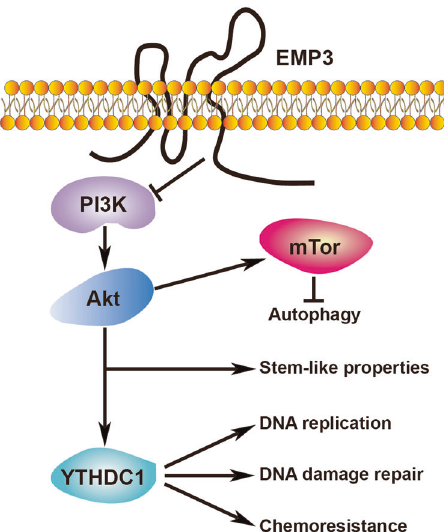
Fig. 7 A schematic fi gure showing EMP3 signaling pathway. EMP3 regulates autophagy, stem-like properties, DNA replication, DNA damage repair and chemoresistance through blocking PI3K-Akt pathway. Modulation of DNA replication, DNA damage repair and chemoresistance by EMP3 is dependent on